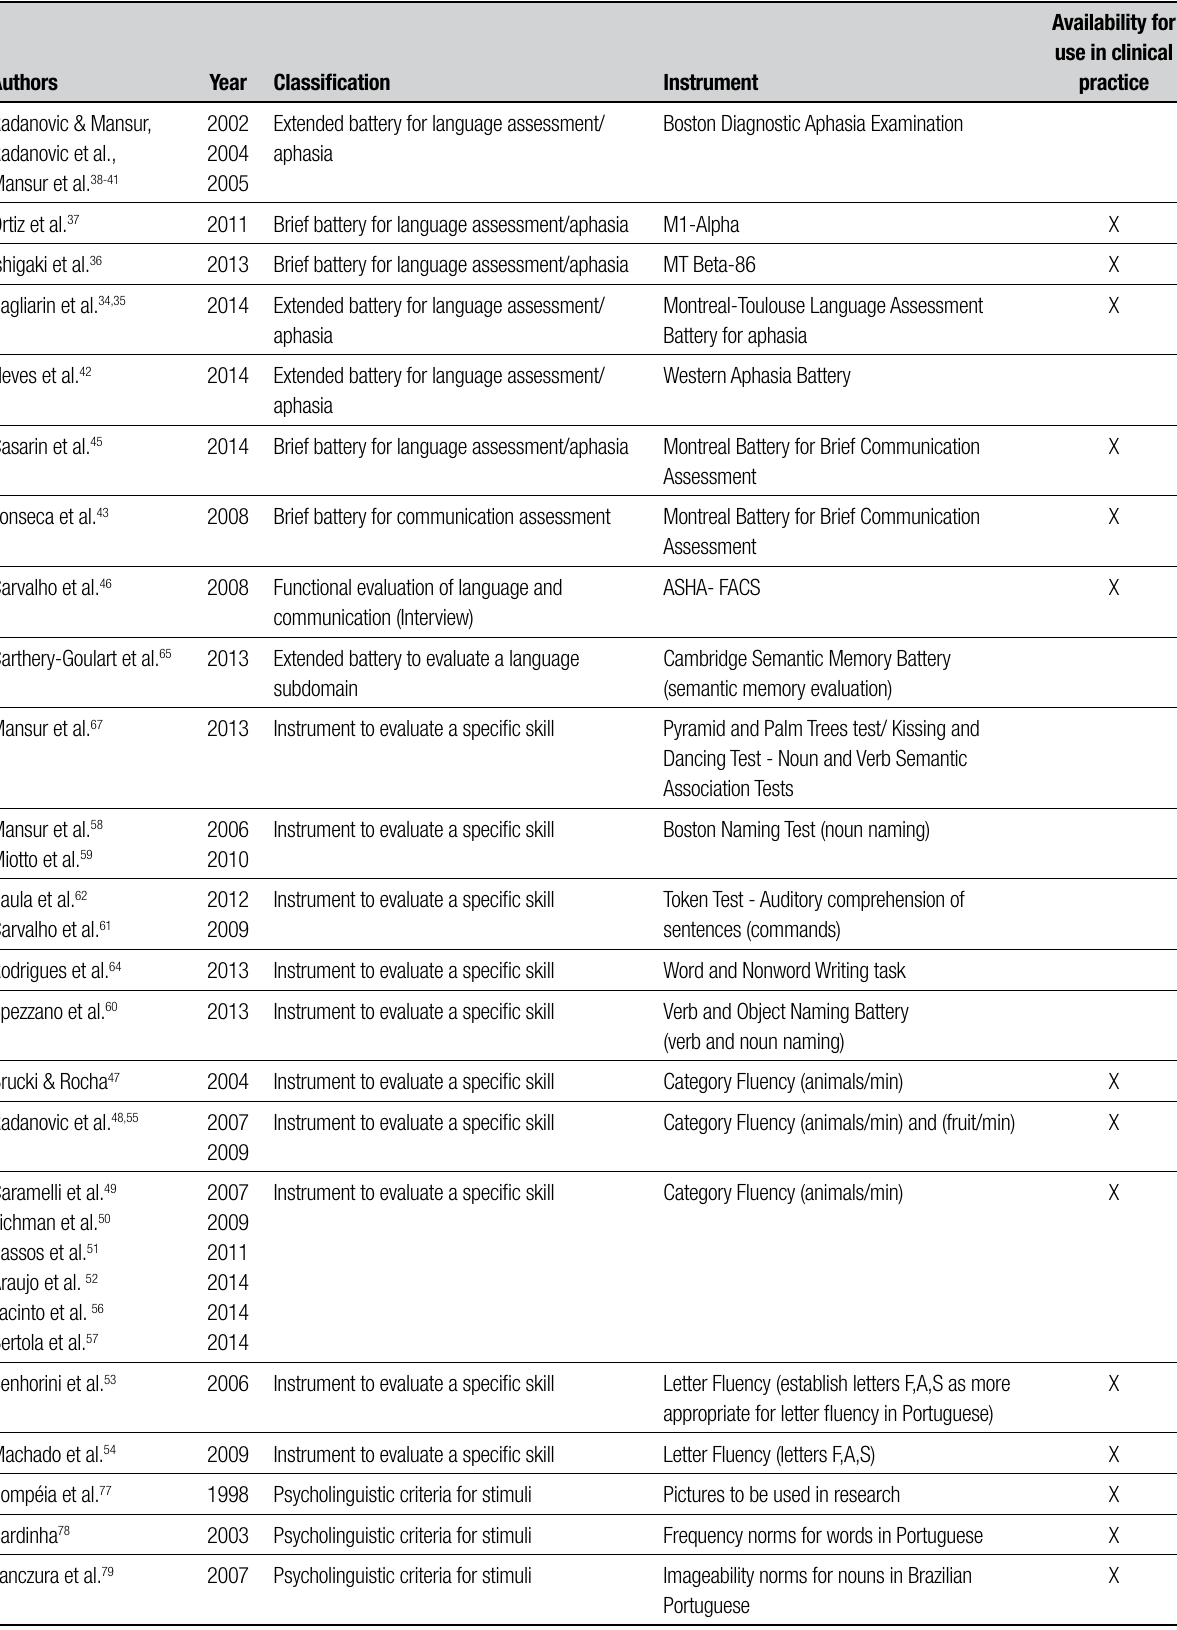
Table 2. Brazilian panorama of instruments for Language